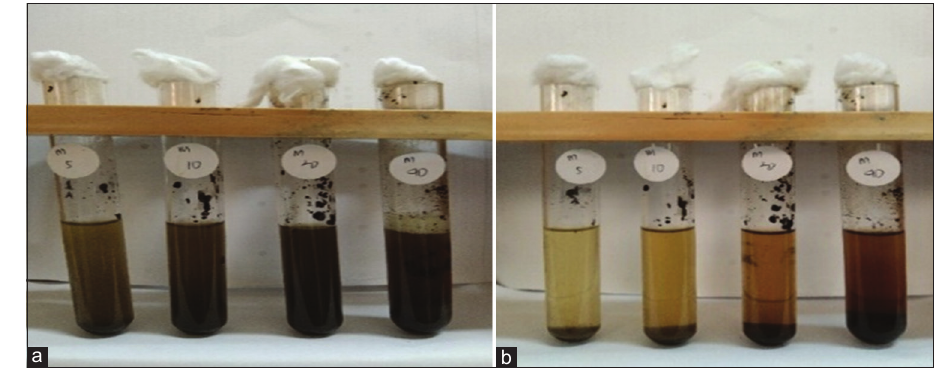
Figure-2: Minimum inhibitory concentration test of Meniran extract (a) before incubation and (b) after incubation.